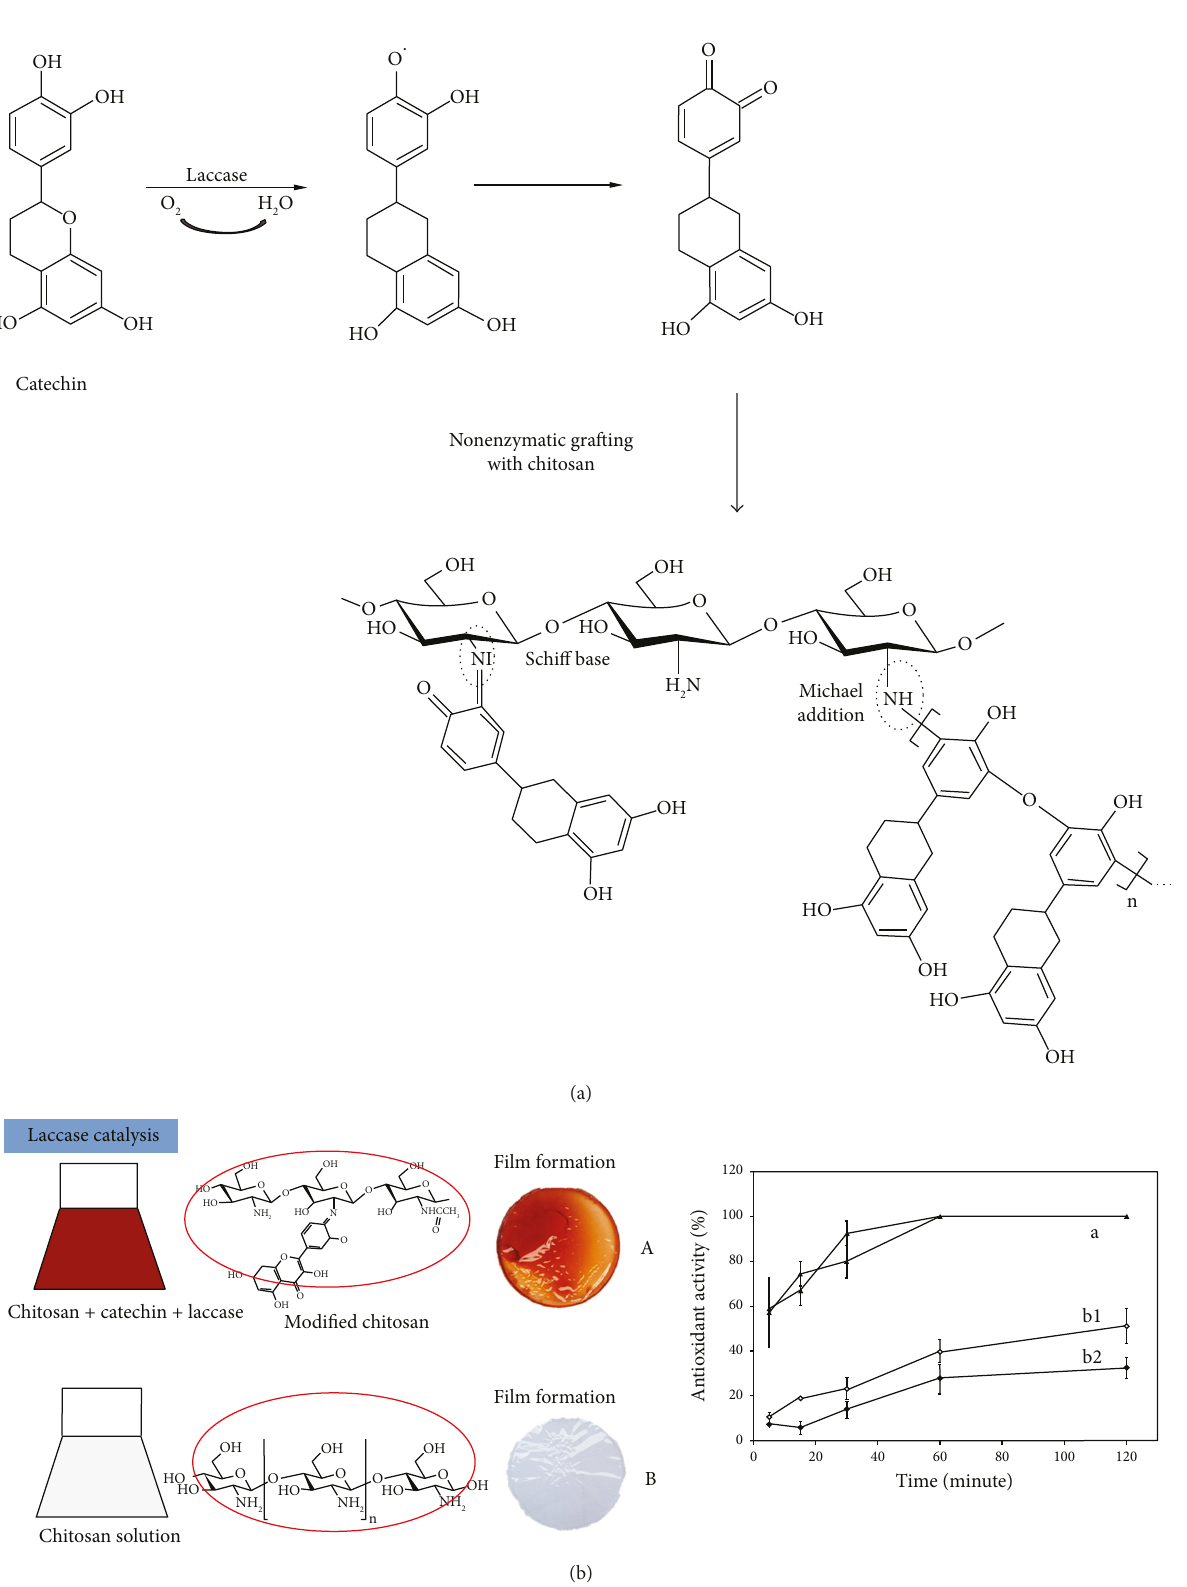
Figure 3: (a) Schematic presentation of enzymatic oxidation of catechin by laccase and nonenzymatic grafting with chitosan and (b) enzymatically modi fi ed chitosan fi lm with catechin fl avonoids (A) and unmodi fi ed chitosan fi lm (B). After modi fi cation with catechin, the antioxidant activity of fi lms reached to 100% in 60 minutes while chitosan fi lm (b) showed less than 40% of radical reduction. b1: 95% of DDA; b2: 64% of DDA (adapted and modi fi ed from